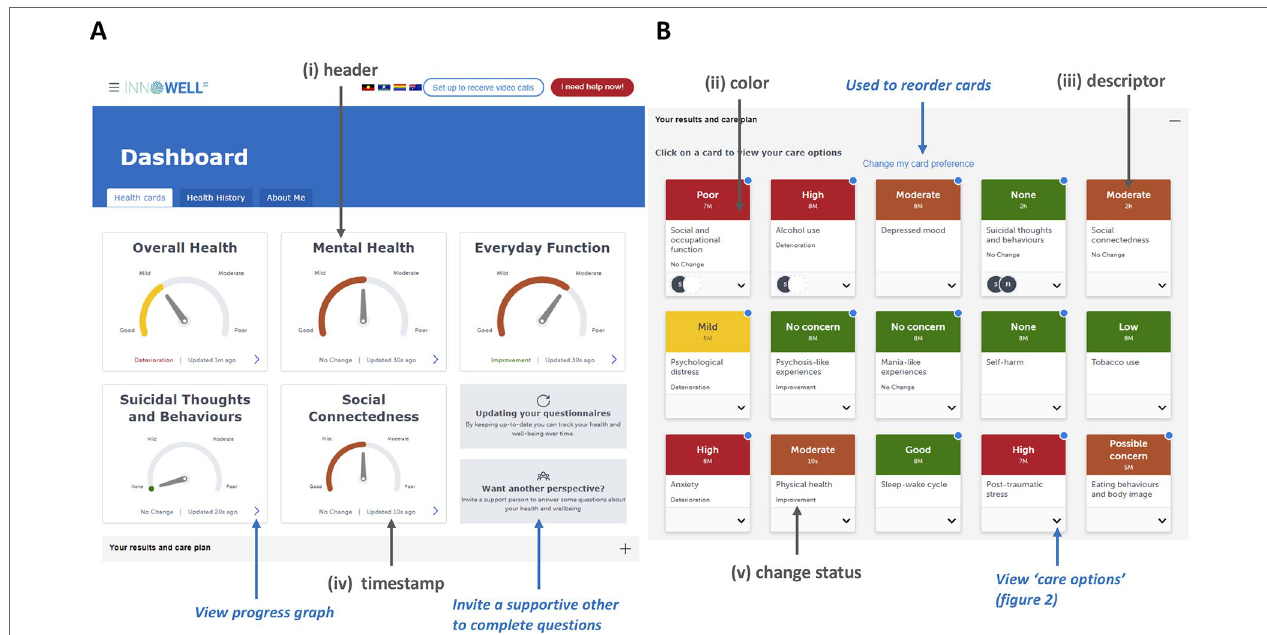
FIGURE 1 | The dashboard of results for the Innowell Platform. Panel (A) shows the summary dashboard which provides a broad overview of the young person’s results for key health domains. Panel (B) shows the more detailed dashboard (i.e., “your results and care plan” section expanded), whereby all of the results from the broad assessment are displayed on different “health cards.” Each domain is accompanied by a scale, the current result (represented using color and a dial), and an indication of personalized change. The Platform allows for the customization of specific domains, questions, and algorithms for this section. The use of color here is to make it easier for young people and clinicians to figure out what might be tracking well or not so well. The color is accompanied by a text description (e.g., high) as well as a timing (e.g., 3M, equal to “3 months”), which is used to indicate how recent the current result is. The middle of the health card presents the title and includes the personalized change status in text (e.g., improvement). The circles presented on the “suicidal thoughts and behaviors” health card provides an example of how the Platform communicates whether or not an intervention is currently active for a particular domain. Here, the initials of the treating clinician are displayed along with the young persons initials to indicate they are working on this together. Gray text and arrows highlight key components described the feedback section of this paper; blue text and arrows highlight other key components. Please note that the image presented here displays the Platform as it exists at the date of this publication, and is subject to further development and